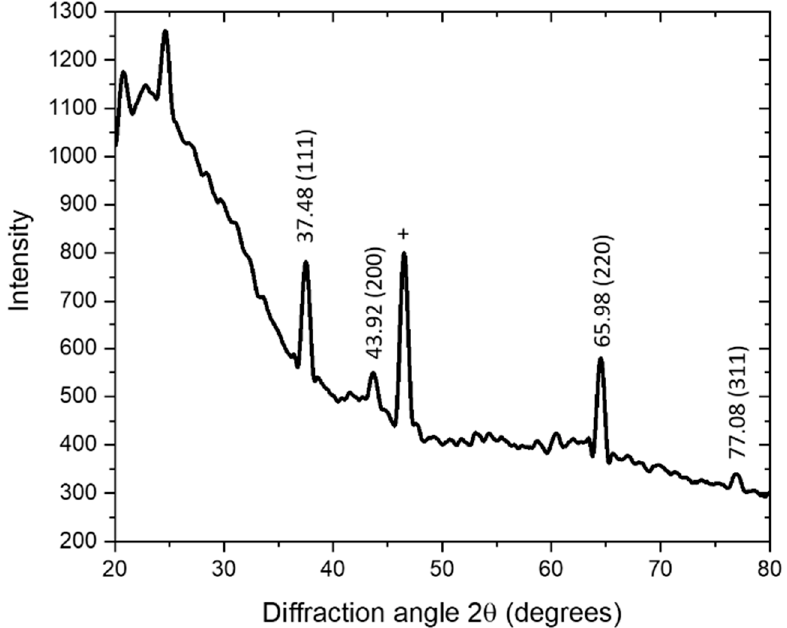
Figure 4. The XRD spectrum of green AgNPs, synthesized using B. flexuosa leave extract. The samples were scanned in the range of 0 ◦ to 80 ◦ at a diffraction angle of 2 θ , with an Ultima IV X-ray diffractometer (Rigaku, Japan) using cobalt radiation (CuK α ), which had a voltage of 40 kV and a current of 30 mA at room temperature.